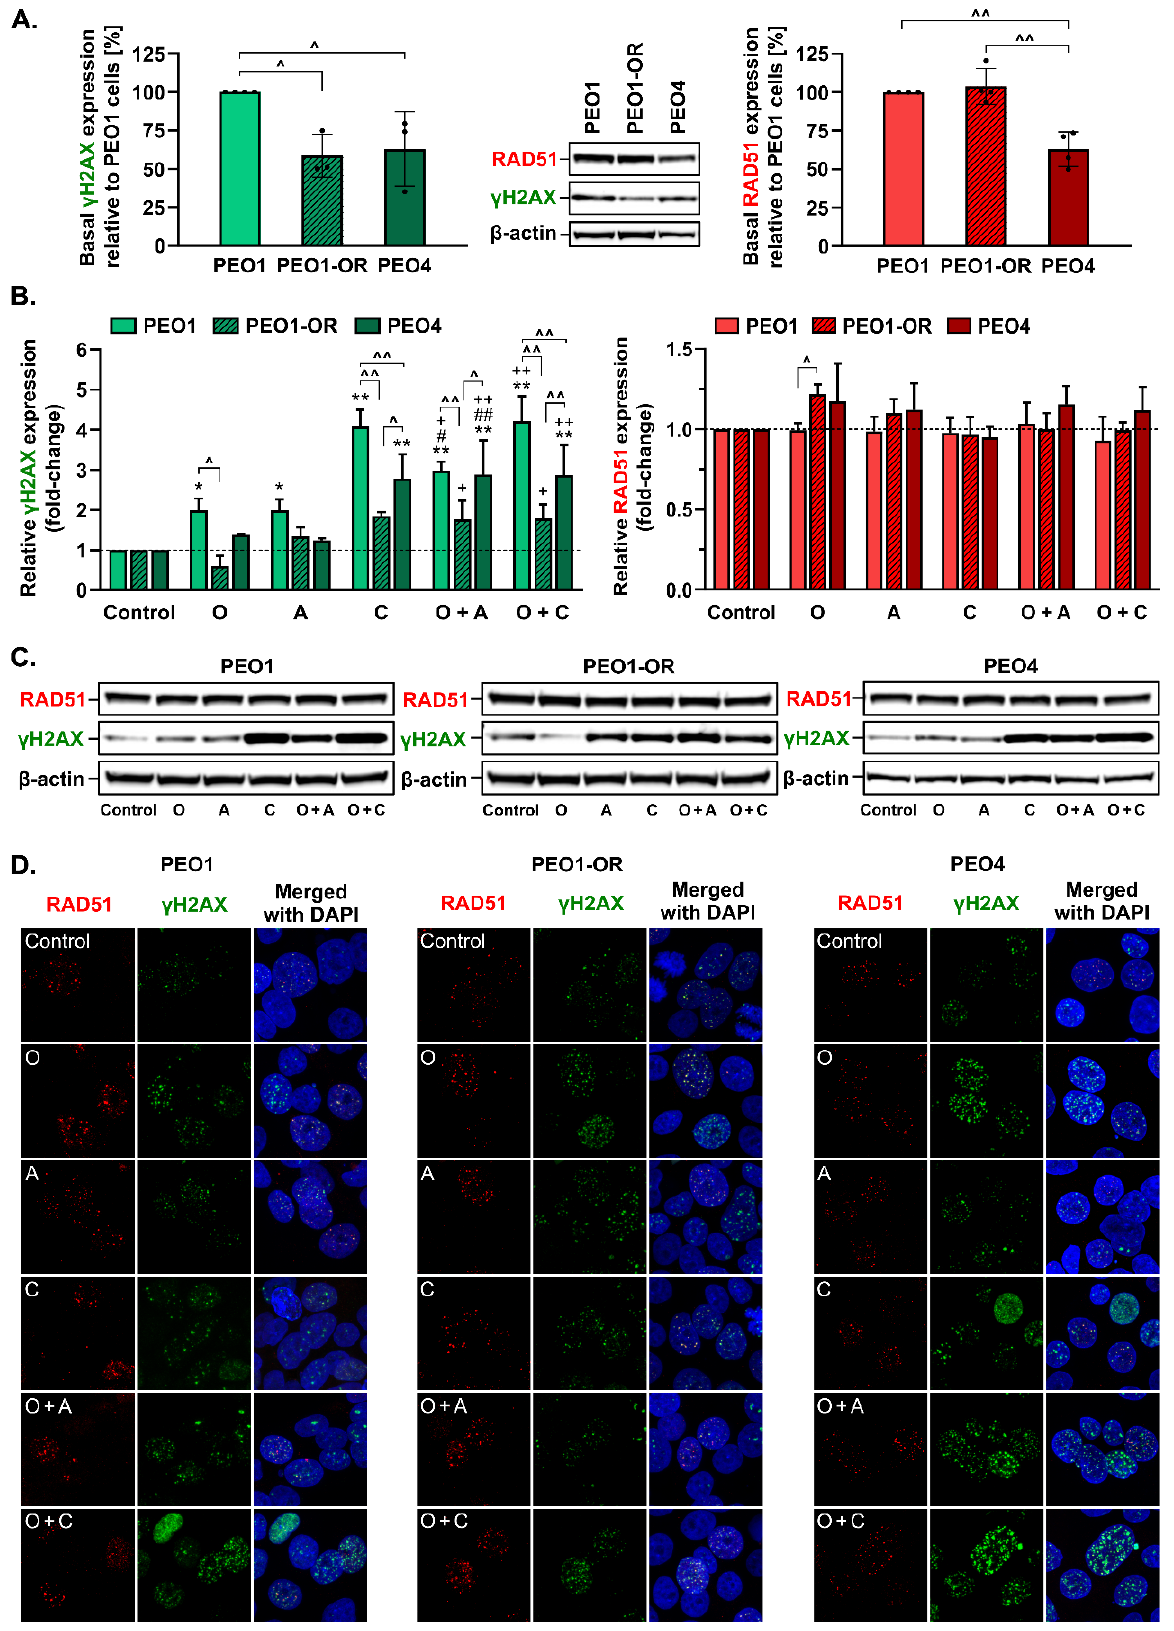
Figure 6. Olaparib-resistant cells exhibit decreased phosphorylation of the DSB marker H2AX in response to inhibitor treatment compared to sensitive OC cell lines. Quantitative Western blot of ( A ) RAD51 and ( B ) phosphorylation of H2AX at Ser139 to γH2AX in OC cell l ines. Basal protein expression calculated from densitometric data relative to PEO1 cells. Cells were incubated for 48 h with olaparib (O, 5 μM), ATRi (A, 0.5 μM), CHK1i (C, 2.5 μM) , or their combinations, and whole- cell lysates prepared immediately afterward. Protein levels following treatment were quantified, with normalization to β -actin as a loading control, and calculated as fold-change relative to un- treated controls. The results are presented as mean ± SD ( n = 3). Statistical significance was assessed